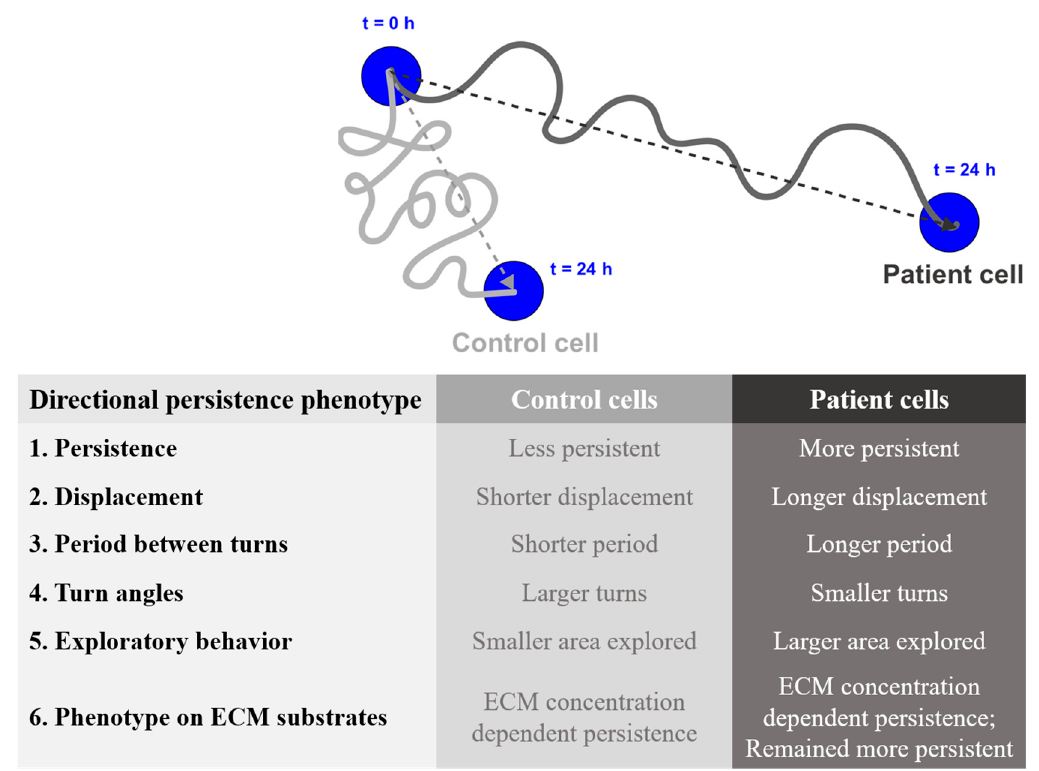
Figure 5. Summary of findings.